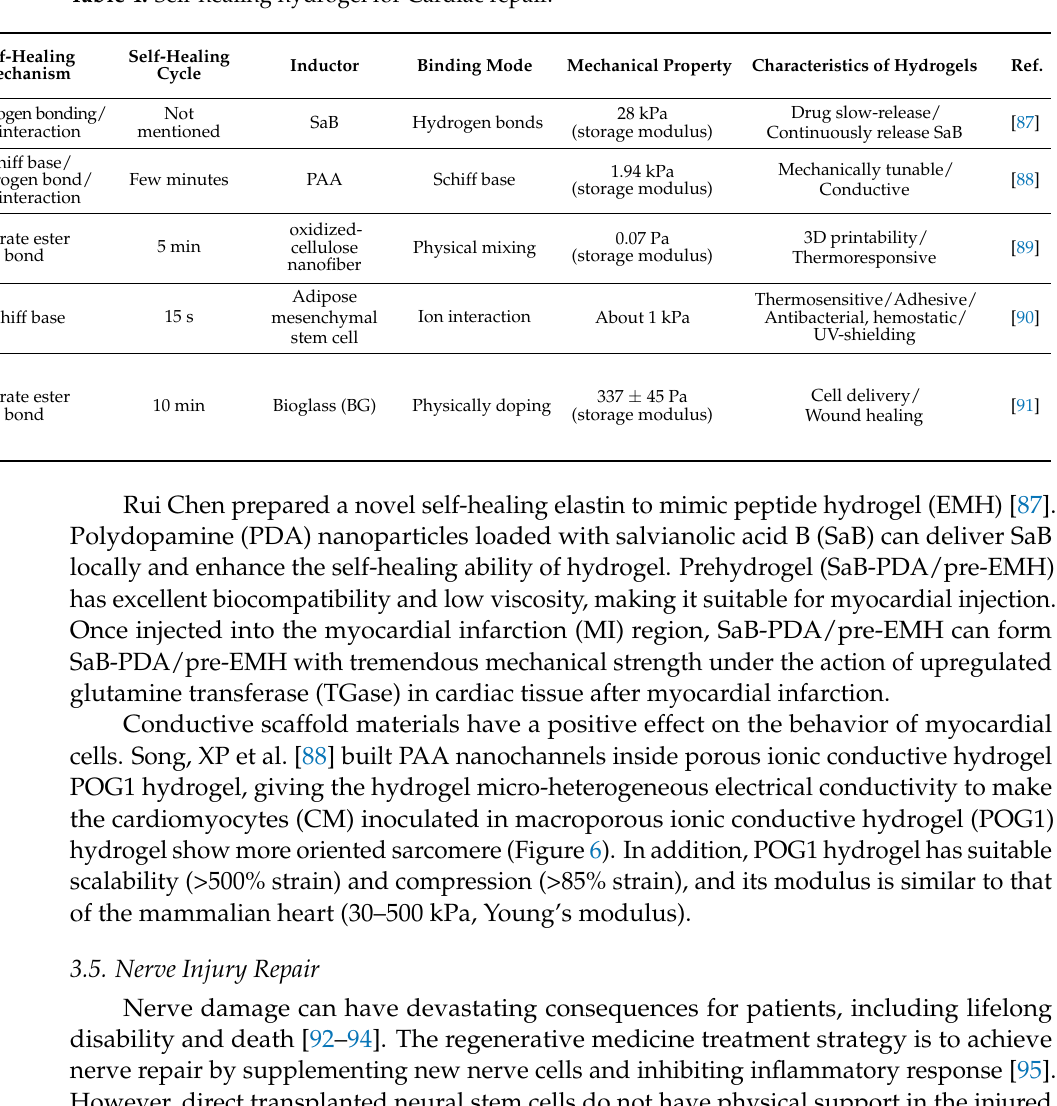
Table 4. Self-healing hydrogel for Cardiac